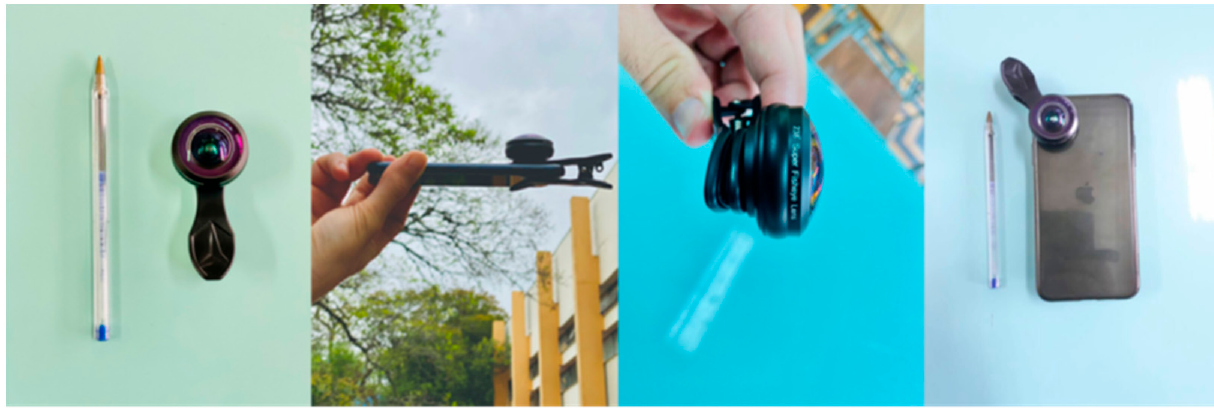
Figure 5. Equipment used to perform the SVF. Source: the authors (2022).